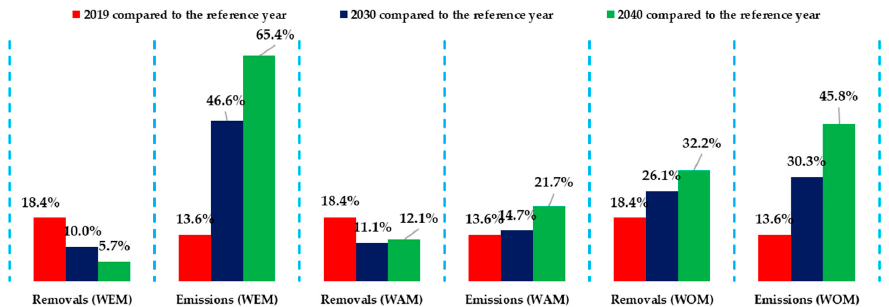
Figure 10. Comparative dynamics of the forecasted evolution of LULUCF GHG emissions vs. GHG removals scenarios.